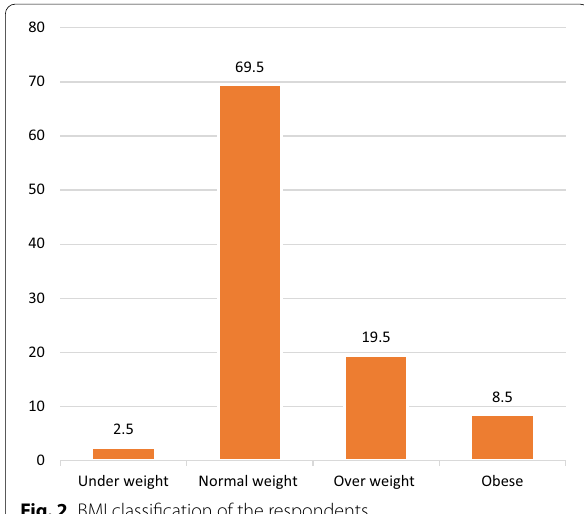
Fig. 2 BMI classification of the